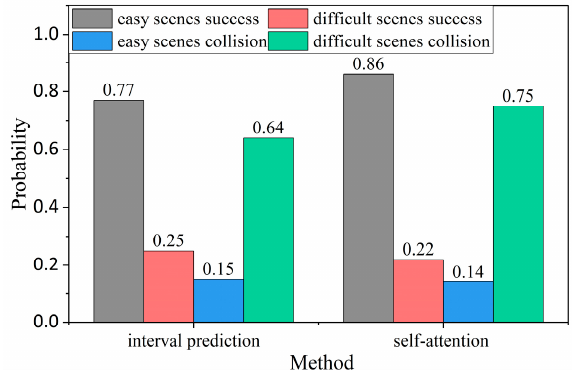
Figure 11. Comparison of interval prediction model and self-attention network test results.